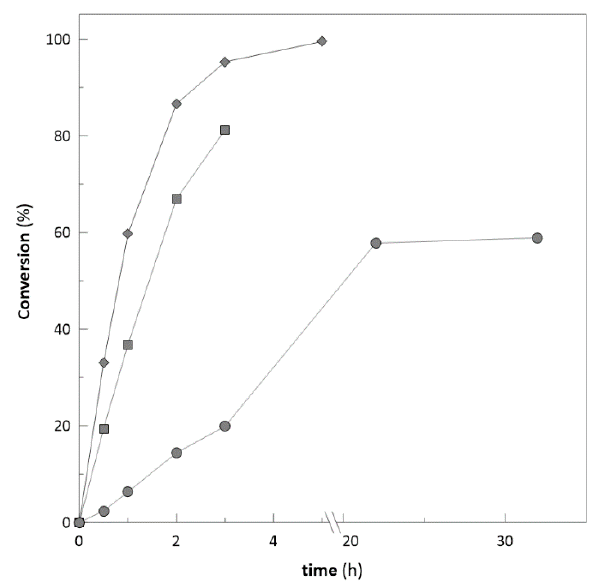
Figure 9. Achieved substrate conversion with different concentration of 3 ′ -hydroxyacetophenone ( ♦ 20 mM; ■ 50 mM; ● 100 mM).